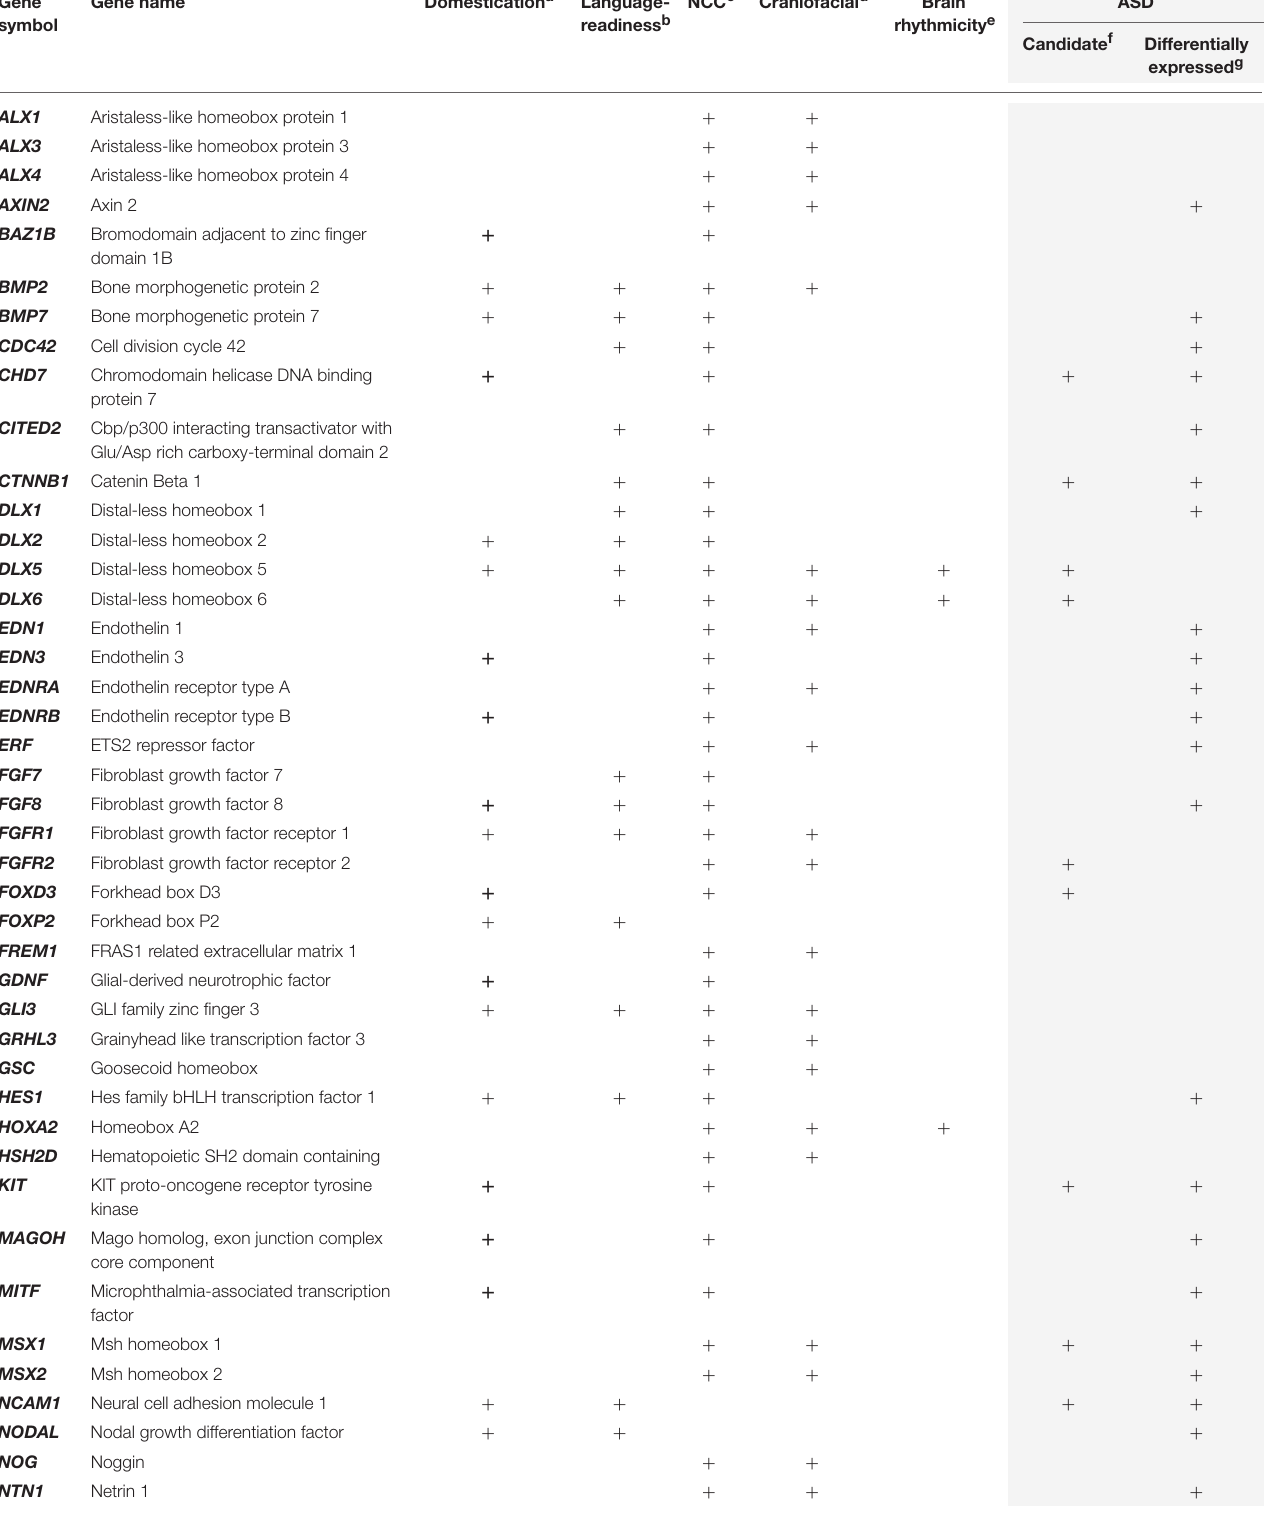
TABLE 1 | List of putative candidate genes for domestication and ASD. Gene